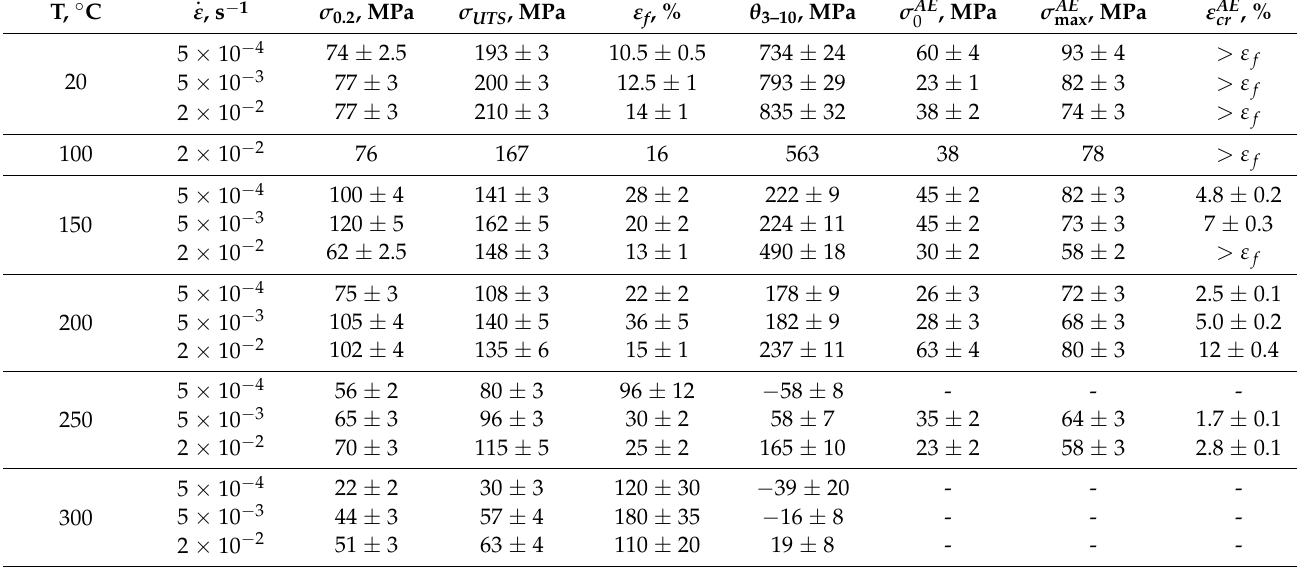
Table 1. Mechanical properties and acoustic emission